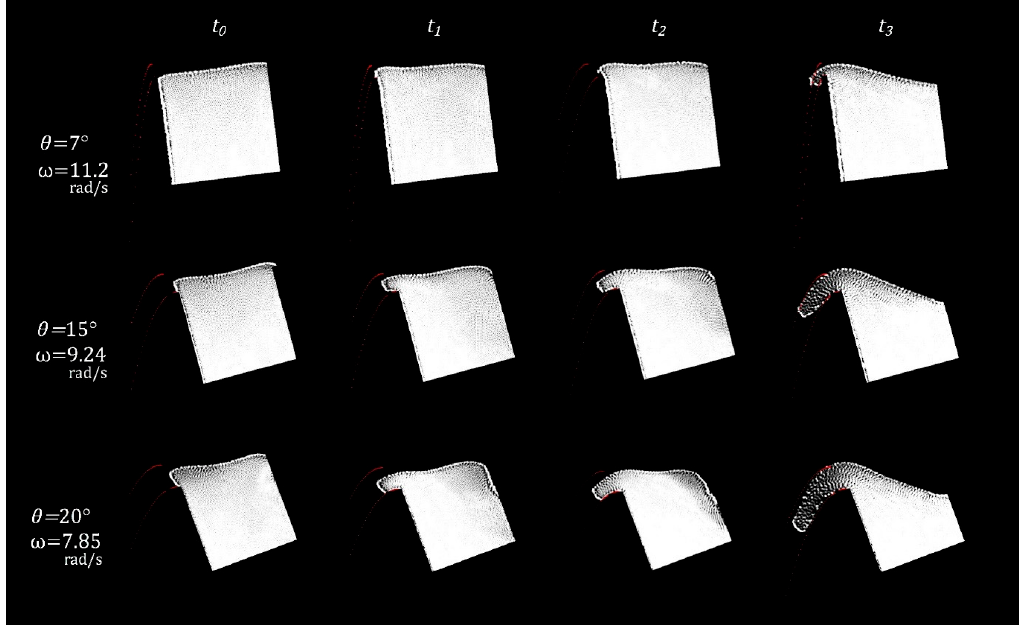
Figure A1. Transient time response of the slosh induction method using different vessel angles of rotation (7 ◦ , 15 ◦ and 20 ◦ ) and at di ff erent periods of time ( t 0 , t 1 , t 2 and t 3 ). t 0 time is transition 2 in Figure 4, where the slosh finds its maximum elevation in the back wall of vessel 1 due to the initial rotation. t 1 is the period of time where the slosh returns to the front wall of vessel 1 to reach, at the beginning of t 2 , the desired elevation of h q (horizontal free surface), and where AFS commutes to CFS for constant flow. t 3 shows the full elevation of the slosh on the front wall, never intended to reach due to the CFS control action. All particles are simulated within the pouring vessel 1.